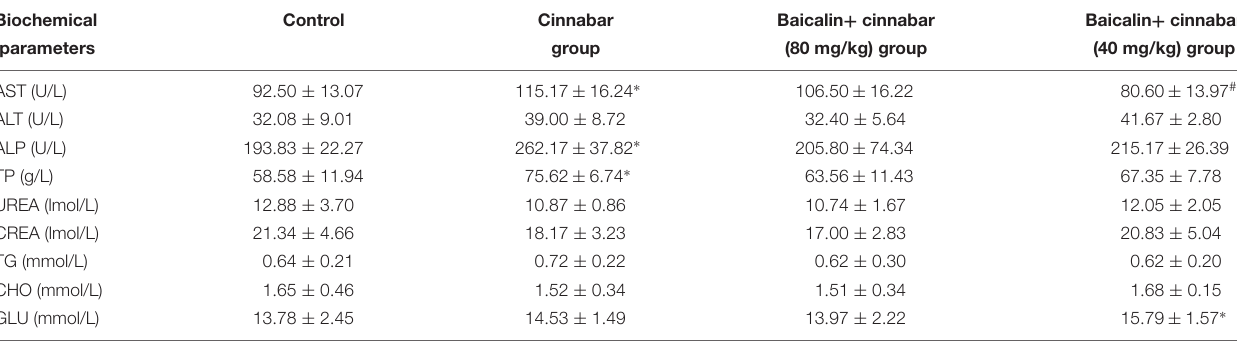
FIGURE 1 | The structure of Baicalin. TABLE 1 | Summary of serum clinical biochemistry